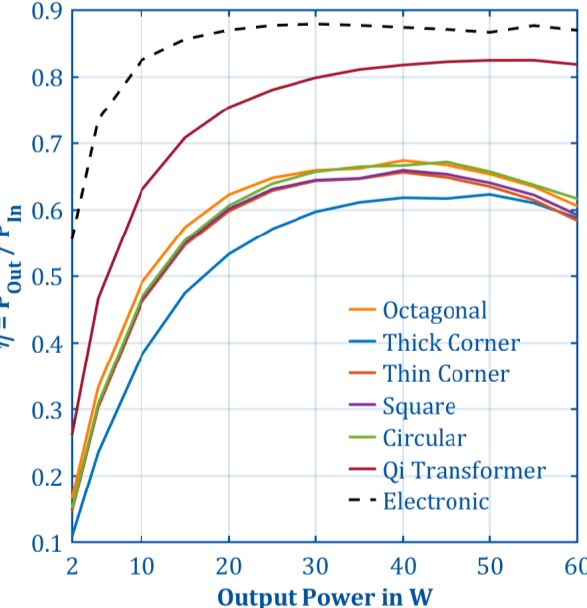
Figure 8. Measurement of the efficiency of the isolated DC power supply as a function of the output power of the transformers and the control electronics at 150 kHz. The efficiency measurement of the electronics was taken without an interconnected transformer, and therefore only the losses of the primary and secondary side electronics were measured, as marked with a dashed line.